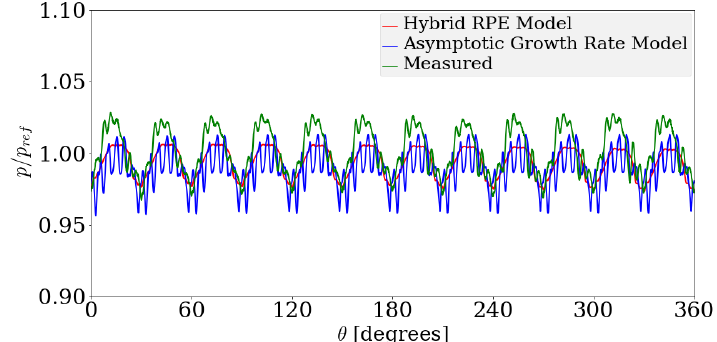
Figure 20. Comparison between delivery pressure ripple for the Asymptotic Growth Rate model, the Hybrid Rayleigh–Plesset Solution approach with experimental data, for an operating speed of 1500 rpm and a suction pressure of − 0.64 bar gauge pressure. The modeled pressure fluctuations are within +0.6% and − 2.7% while the measured data is within +2.8% and − 3.2% of the reference